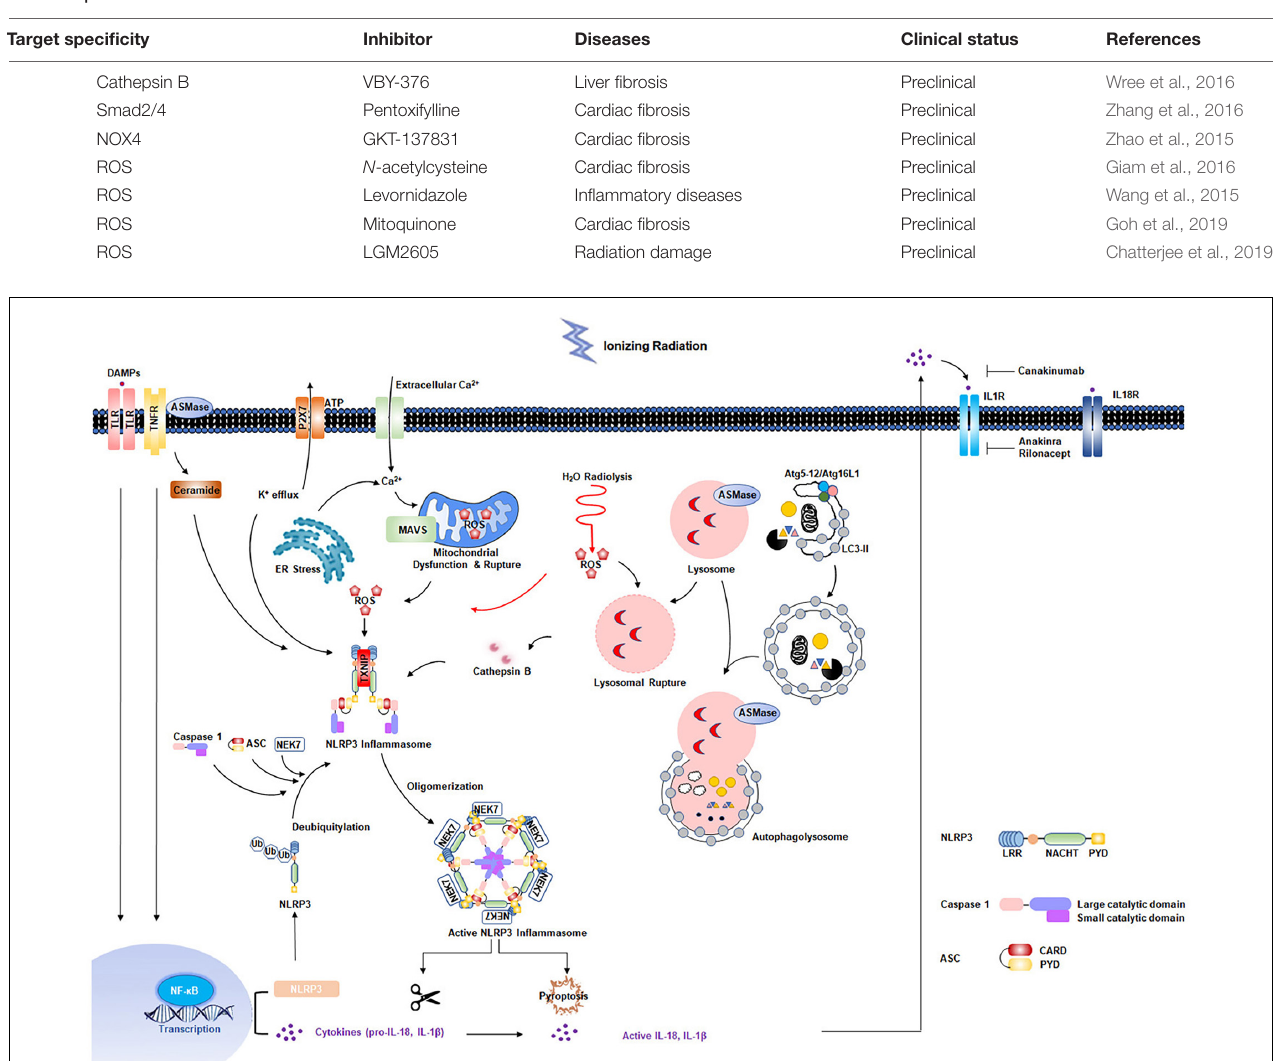
FIGURE 2 | Multiple effects of radiation on NLRP3 inflammasome activation. Radiation-induced NF- κ B activation is responsible for the upregulation of NLRP3 and pro-interleukin-1 β . Second signals come from multiple pathways: water radiolysis, K + efflux, endoplasmic reticulum (ER) stress, mitochondrial dysfunction, ceramide pathway, and lysosomal rupture pathways, most of which appear to converge in the production of reactive oxygen species (ROS). The primary and secondary signals triggers the NLRP3 inflammasome activation, resulting in the maturation of caspase 1 and IL-1 β . Two evolutionarily conserved degradation pathways, ubiquitin-proteasome and autophagy, negatively regulate NLRP3